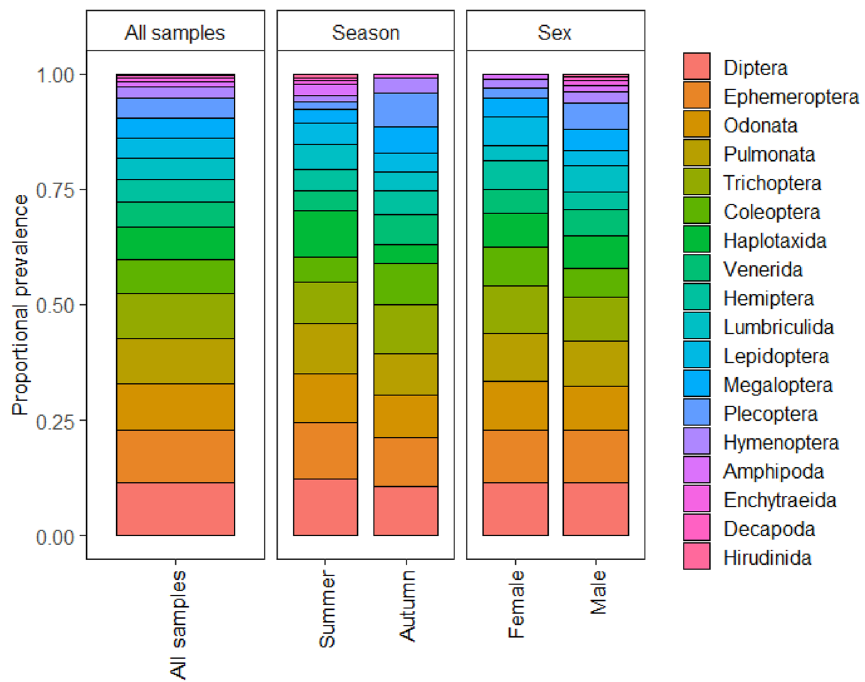
Figure 4. The proportional prevalence of orders across all samples, seasons, and sexes from cheek pouches of 29